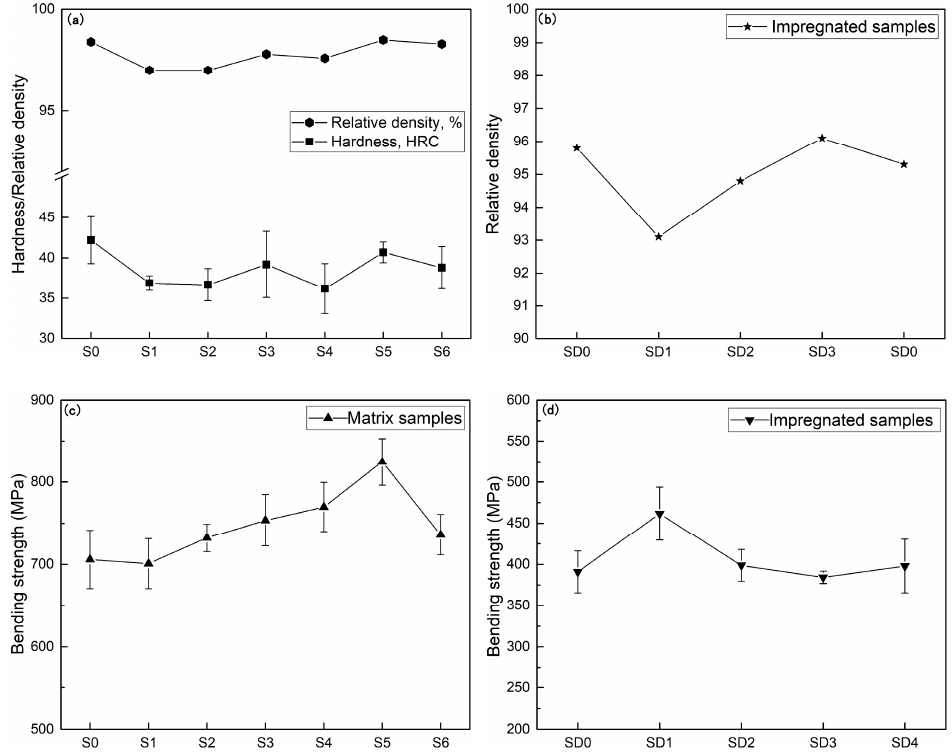
Figure 6. Mechanical properties of samples. ( a ) The relative density and HRC values of matrix samples; ( b ) The relative density of impregnated diamond samples; ( c ) The bending strength of matrix samples; ( d ) The bending strength of impregnated diamond samples.